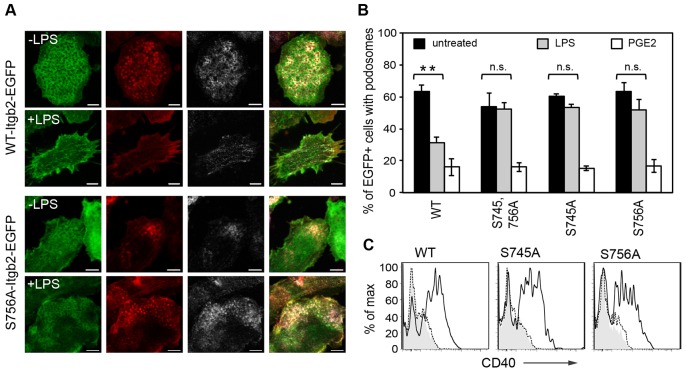
Mutation of Ser756 to Ala blocks acute LPS-stimulated podosome loss. (A) Itgb2-null BMDCs were infected with retroviral constructs expressing WT-Itgb2-EGFP or S756A-Itgb2-EGFP (green). Cells were treated as indicated with (+LPS) or without (–LPS) 50 ng/ml LPS for 30 minutes, then fixed and stained to visualize F-actin (red; Alexa-Fluor-555) and α-actinin 4 (grey; Alexa-Fluor-633). Podosomes reconstituted with the S756A-Itgb2-EGFP mutant were resistant to the LPS-stimulated disassembly seen for WT-Itgb2-EGFP (A; green). Images were acquired using a Zeiss LSM700, as in Fig. 1. Scale bars: 5 µm. (B) Percentage of EGFP+ cells that contain podosomes when reconstituted with Itgb2-EGFP constructs containing double or single Ser to Ala mutations (S745A and S756A, or either S745A or S756A) with or without treatment with LPS (50 ng/ml) or prostaglandinE2 (10 µg/ml) for 30 minutes, before fixation and staining as above. LPS-driven podosome loss, though significant (**P = 0.005) for WT-Itgb2-EGFP, was not significant in cells expressing the single S745A or S756A β2 mutants (paired t-tests). (C) CD40 expression in cells expressing WT, S745A or S756A Itgb2 was assessed by flow cytometry in control cells (dashed line) and after 20 hours of LPS treatment (solid line).